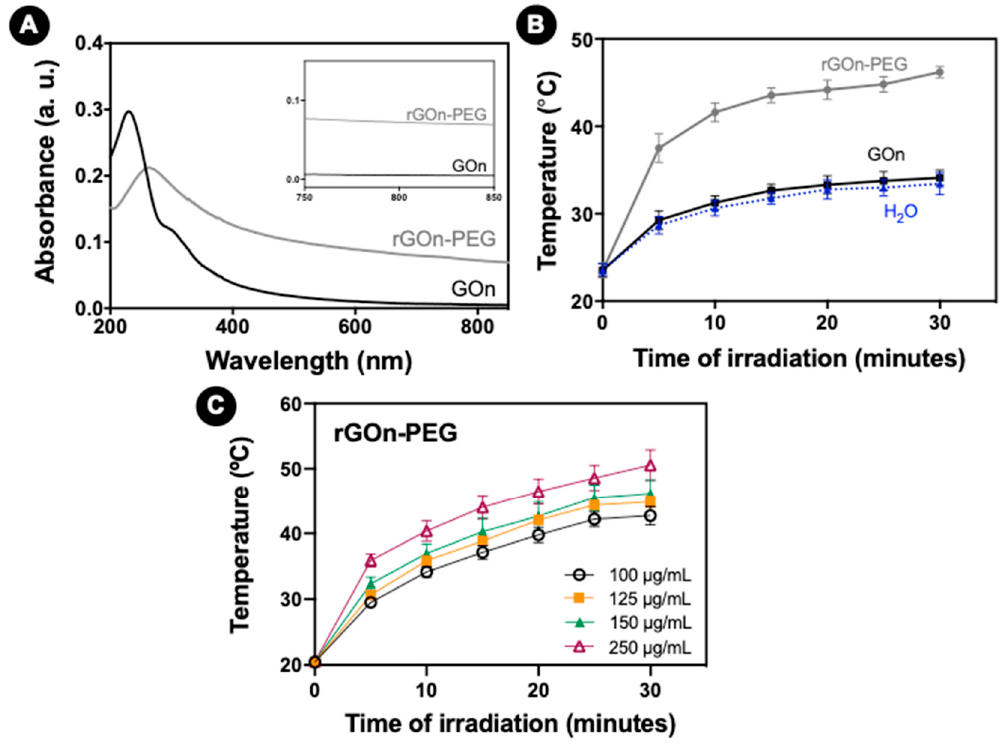
Figure 6. NIR absorption capacity of GBM. ( A ) UV / vis absorption curves of GOn and rGOn-PEG. The inset shows a zoom-in view of the curves in the NIR range from 750 nm to 850 nm. ( B ) Photothermal heating curves of water (dashed line, blue), and GOn (black) and rGOn-PEG (grey) aqueous dispersions at a concentration of 250 μ g mL − 1 in water. ( C ) Concentration-dependent effect on photothermal heating curves for rGOn-PEG.